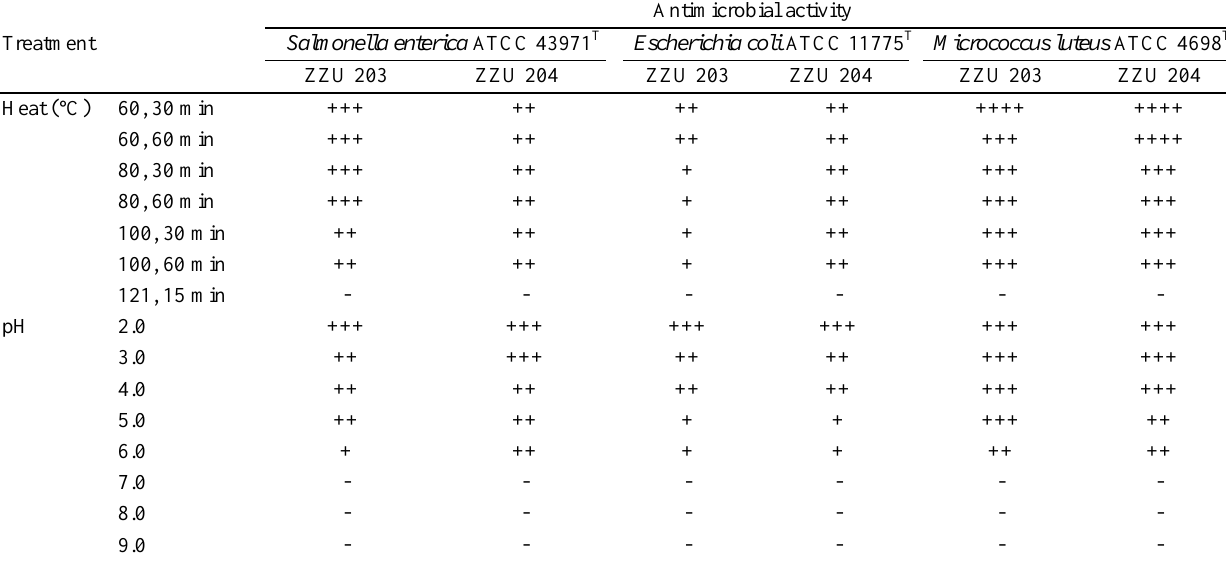
Table 6. Effects of temperature and pH on the antimicrobial activity of ZZU 203 and 204